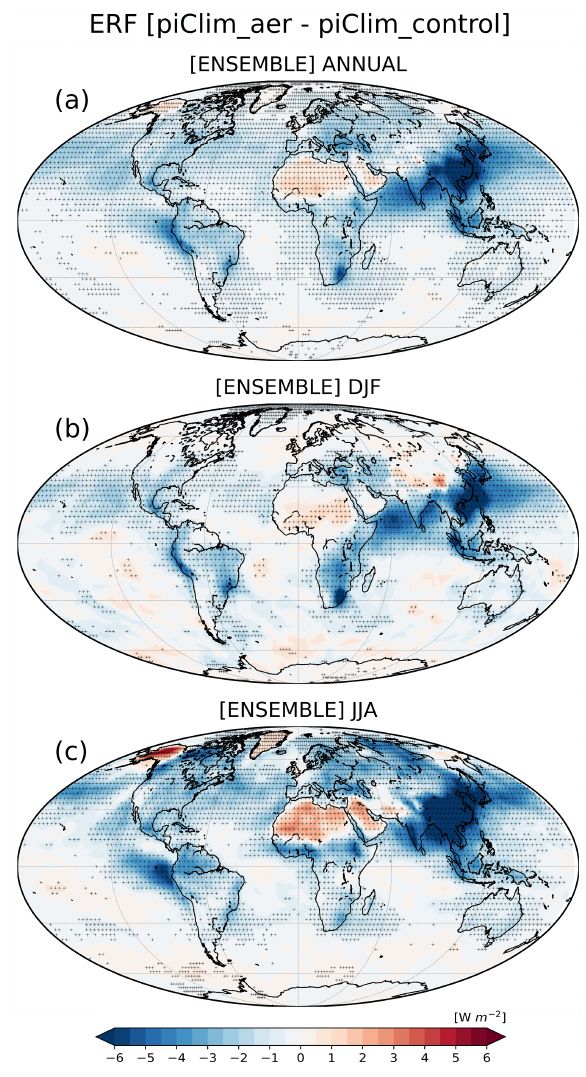
Figure 3. Differences between piClim-aer and piClim-control in the net radiative flux (Wm − 2 ) at TOA including both SW and LW (all- aerosol ERF) for the ensemble of 10 models (a) on an annual basis, (b) for DJF and (c) for JJA. The dot shading indicates areas in which the differences are statistically significant at the 95% confidence